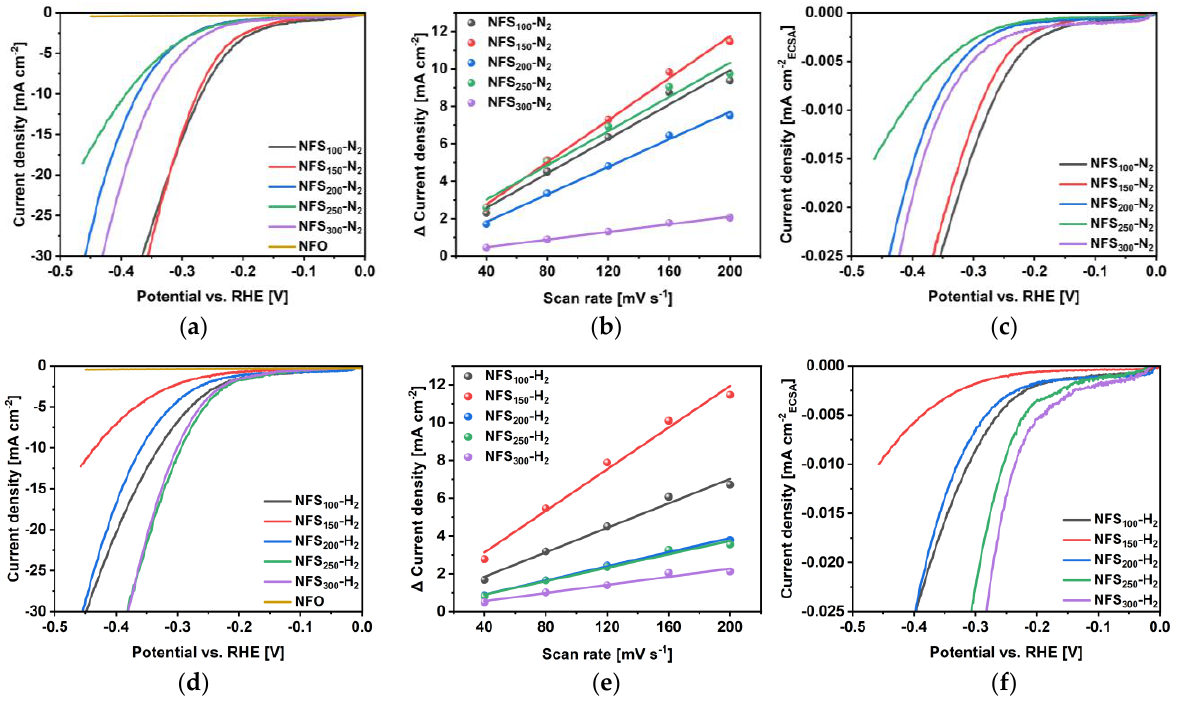
Figure 2. Electrochemical performance data of the NFS −N 2 electrocatalysts showing ( a ) non − Normalized LSV curves, ( b ) C DL values obtained by cyclic voltammetry and ( c ) LSV curves normalized by the ECSA. Electrochemical performance data of the NFS −H 2 electrocatalysts showing ( d ) non − Normalized LSV curves, ( e ) C DL values obtained by cyclic voltammetry and ( f ) LSV curves normalized by the ECSA.